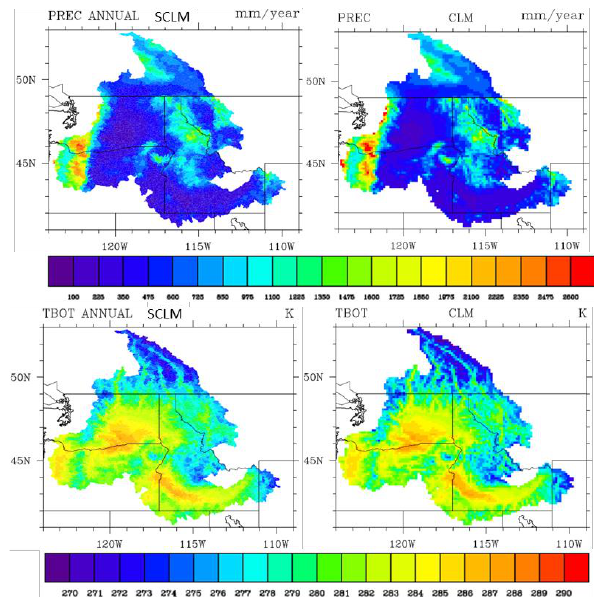
Figure 2. Comparison of precipitation and air temperature repre- sentation in the two modeling